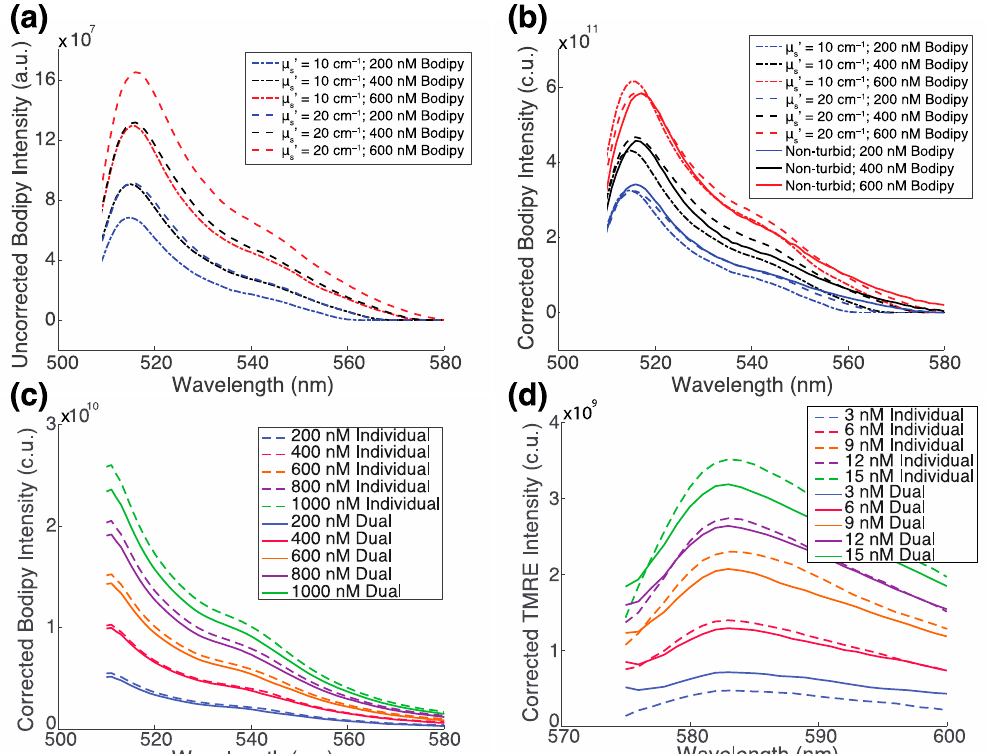
Figure 2. There is no optical crosstalk TMRE and Bodipy FL C16 in mixed samples. ( a ) Measured and ( b ) corrected fluorescence spectra at three Bodipy FL C16 concentrations, each with a fixed absorption coefficient ( µ a ) of 0.3 cm − 1 and a high (20 cm − 1 ) or low (10 cm − 1 ) reduced scattering coefficient ( µ s (cid:48) ). The Bodipy FL C16 concentrations are 200 nM, 400 nM, and 600 nM, respectively. ( c ) Corrected Bodipy FL C16 spectra with (solid lines) and without (dashed lines) 12 nM TMRE. Bodipy FL C16 concentrations are 200, 400, 600, 800, or 1000 nM and ( d ) corrected TMRE spectra with (solid lines) and without (dashed lines) 200 nM Bodipy FL C16. TMRE concentrations are 3, 6, 9, 12, or 15 nM. In each phantom in ( c , d ), the reduced scattering coefficient ( µ s (cid:48) ) is 10 cm − 1 and there is no absorber present. Intensity is reported in arbitrary units (a.u.) prior to correction and in corrected units (c.u.) after correction. The color indicates the same fluorophore concentration; dashed line = high scatter, dotted line = low scatter, and solid line = true fluorescence in a non-turbid solution. All fluorescence intensities are reported in corrected units